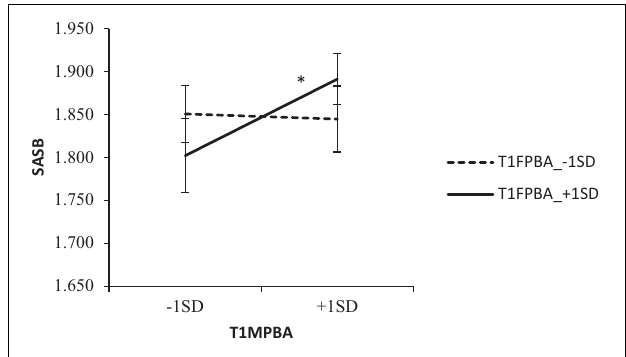
FIGURE 1 | Interaction of fathers’ and mothers’ PBA at Time 1 with students’ anti-social behavior at Time 2 (SASB: Students’ anti-social behavior; T1MPBA: Time 1 mothers’ parental